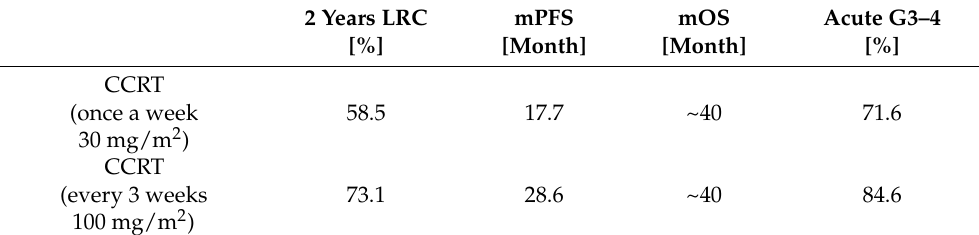
Table 4. Clinical trial 3 CCRT (once a week 30 mg/m 2 ) vs. CCRT (every 3 weeks 100 mg/m 2